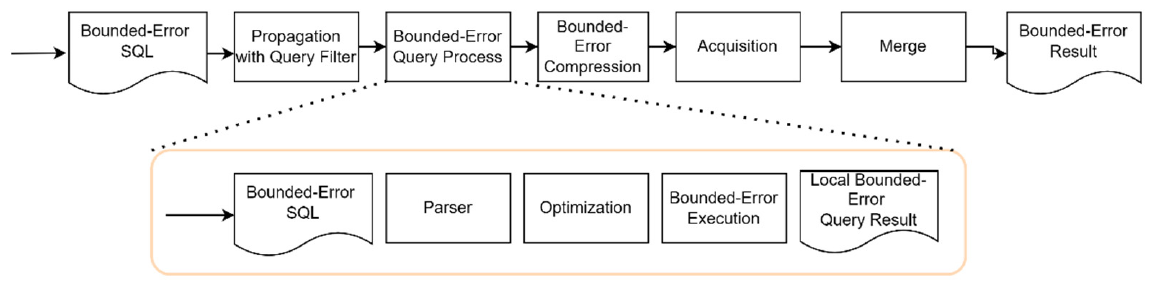
Figure 3. The flowchart of the OBEQ system.